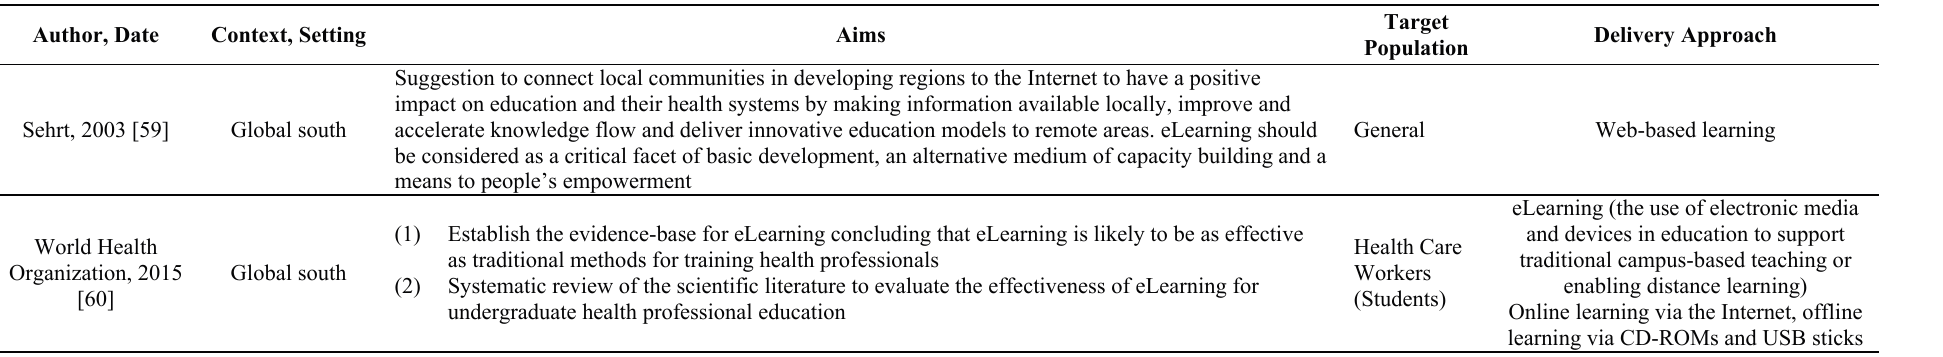
Table 3. Summary of findings from 2 non-peer-reviewed articles of eLearning in developing